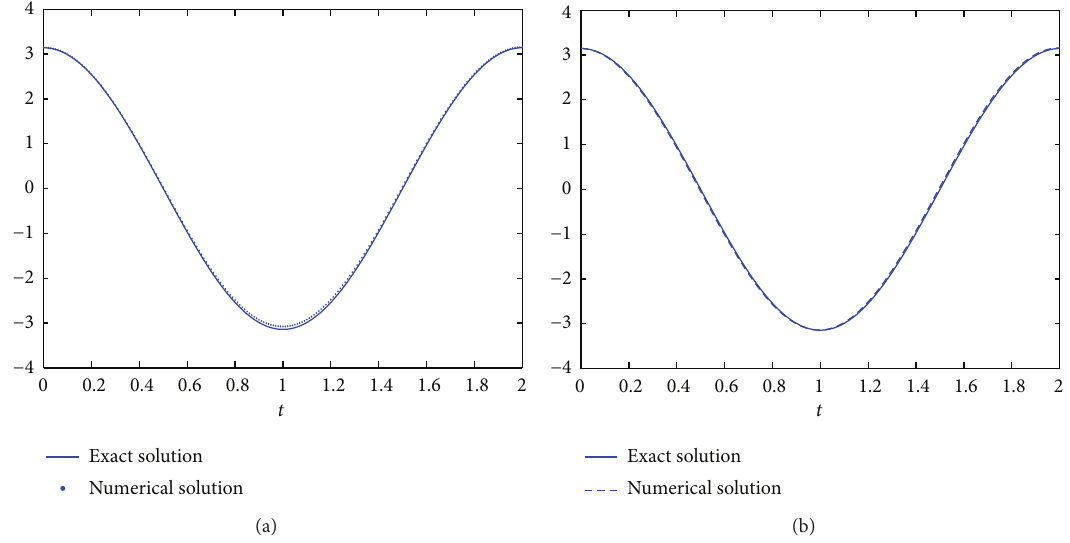
̂𝑓(𝑡) with 𝛾 = 0.001 , (a) MLS and (b) FDM.